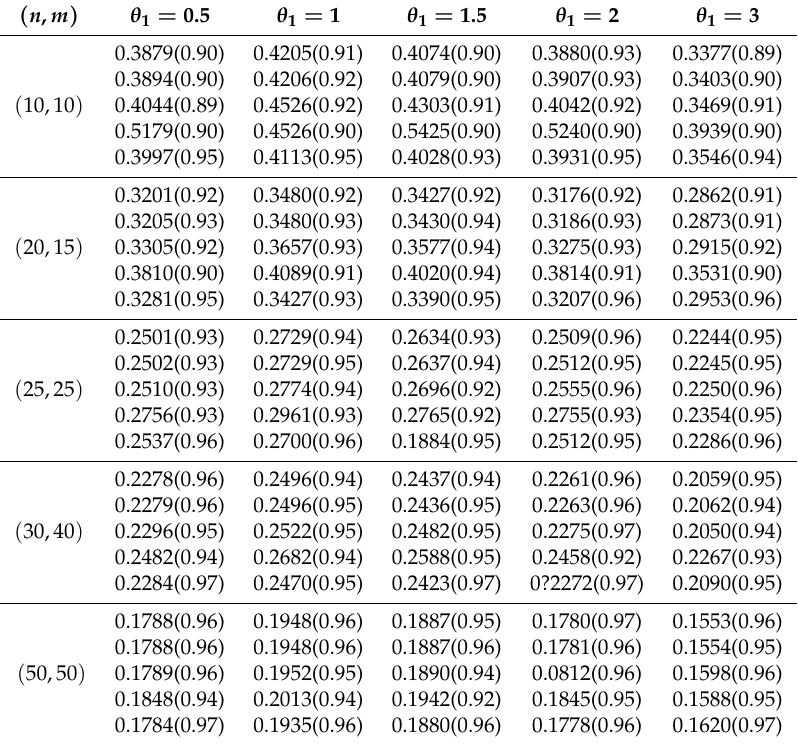
Table 2. Average confidence lengths and coverage